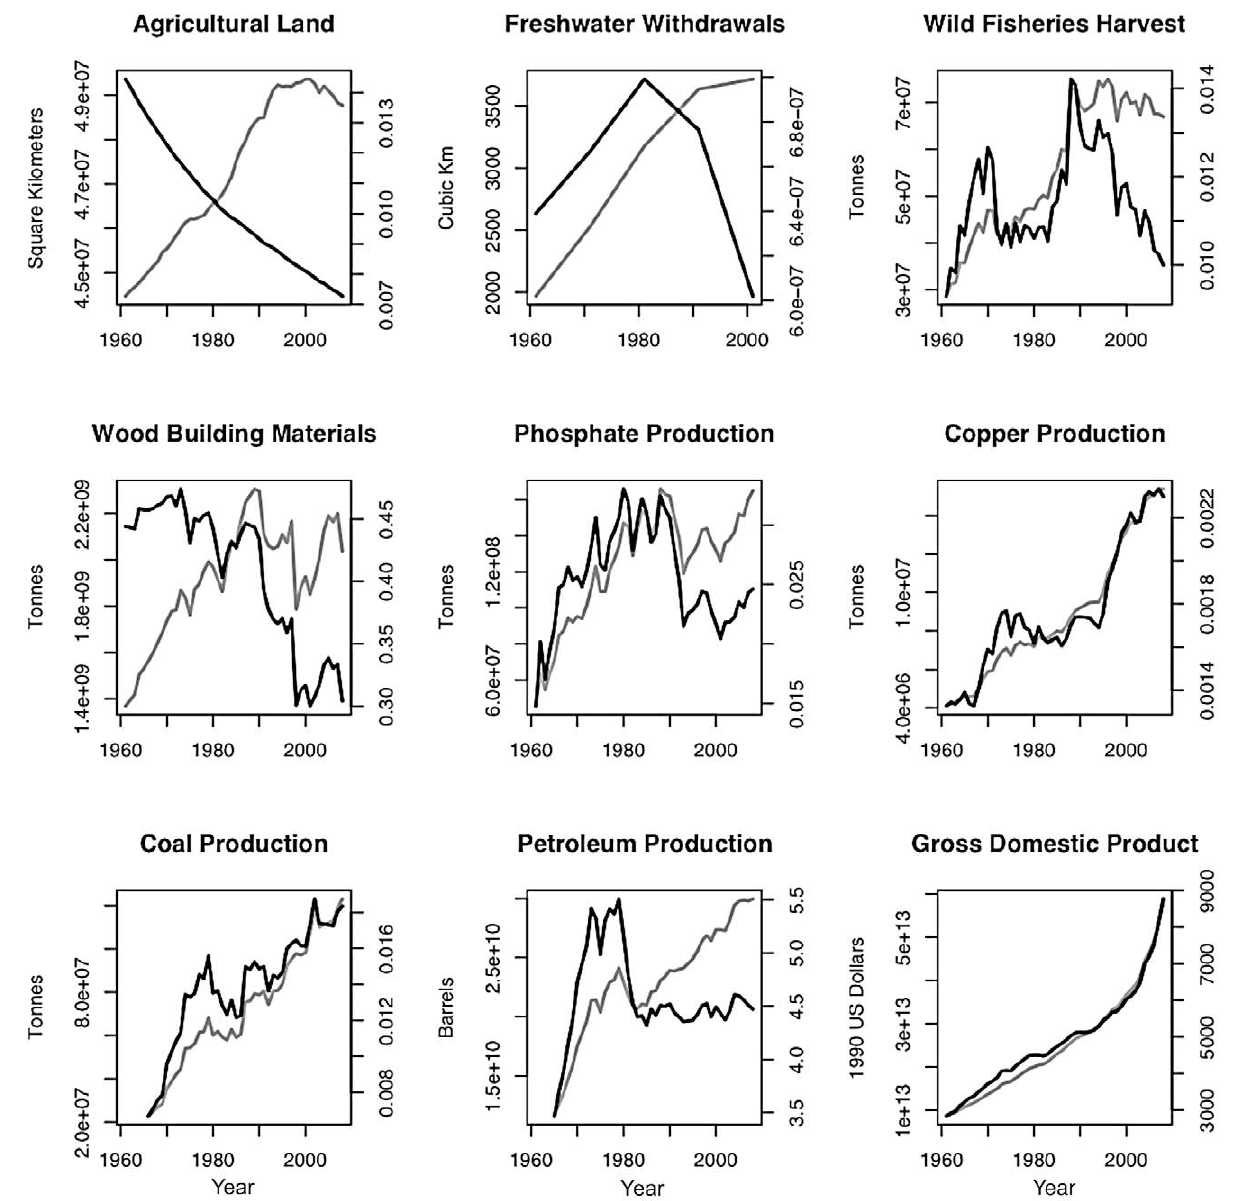
Figure 3. Global trends in total and per capita consumption of resources and GDP from 1961 to 2008. Total global use/production is represented by the grey line using the axis scale on the left side of each diagram. Per capita use/production is represented by the black line using the axis scale on the right side of each diagram. Per capita values represent the total values divided by global population size as reported by the World Resources Institute (http://earthtrends.wri.org/). The y -axes are untransformed and scaled to allow for maximum dispersion of variance. Individual sources for global use/production values are as follows: Agricultural land in square-km is from the World Development Indicators Database of the World Bank (http://data. worldbank.org/data-catalog/world-development-indicators) and represents the sum of arable, permanent crop, and permanent pasture lands (see